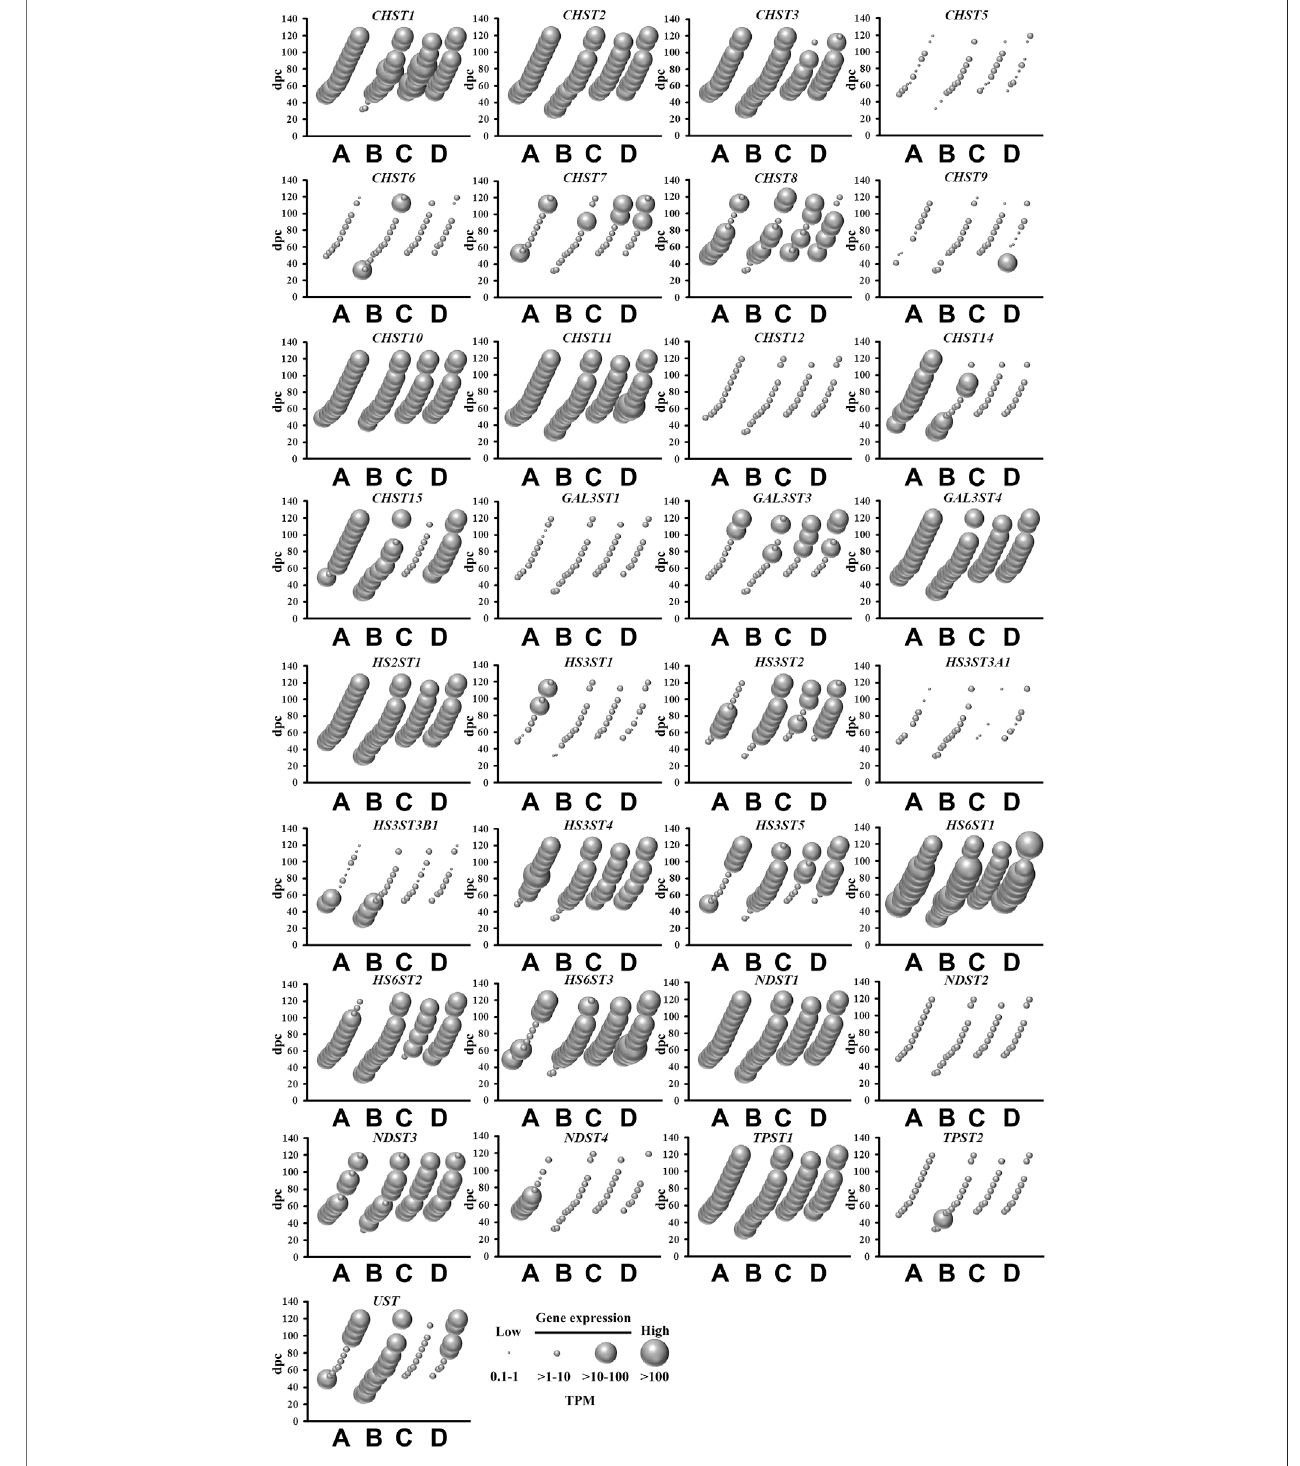
FIGURE 3 | Spatial and temporal mRNA expression of membrane-bound sulfotransferases in fetal brain regions (A) cerebrum, (B) brainstem, (C) diencephalon, and (D) cerebellum. dpc, days post-conception. TPM, transcripts per million.